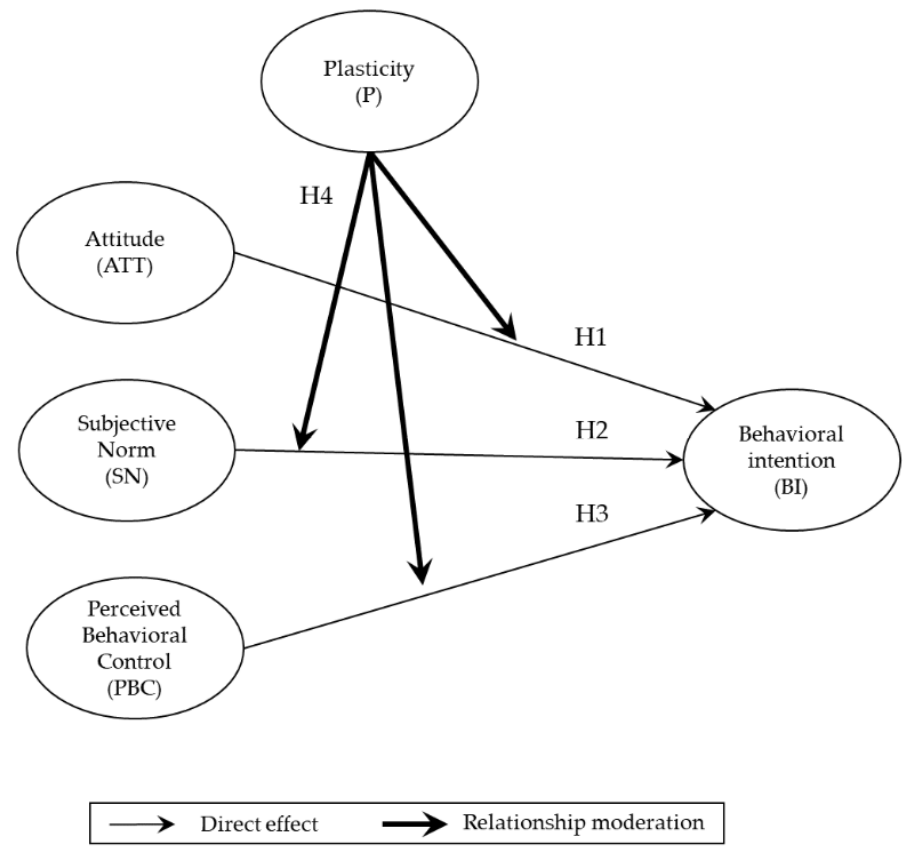
Figure 1. Proposed model and